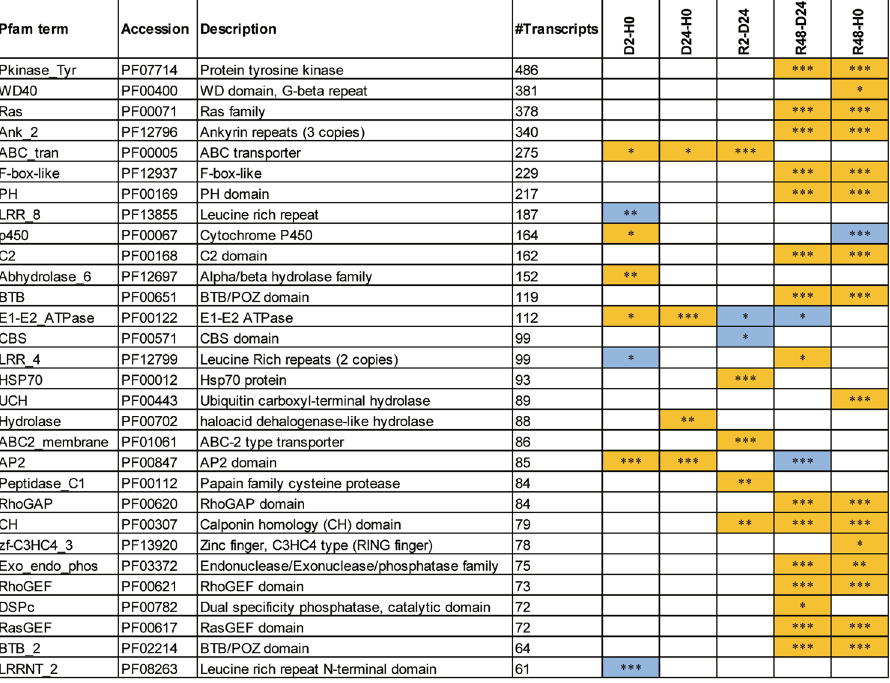
(LEA) group protein coding transcripts (Supplementary Fig. S6) as well as the HSP90, HSP20 and HSP33 family transcripts (Supplementary Fig. S7). The HSP90 transcripts exhibited similar expression patterns with HSP70. Impressively, the LEA protein-coding transcripts were mostly accumulated in desiccated tissues, maintained upon early rehydration and depleted following full recovery.